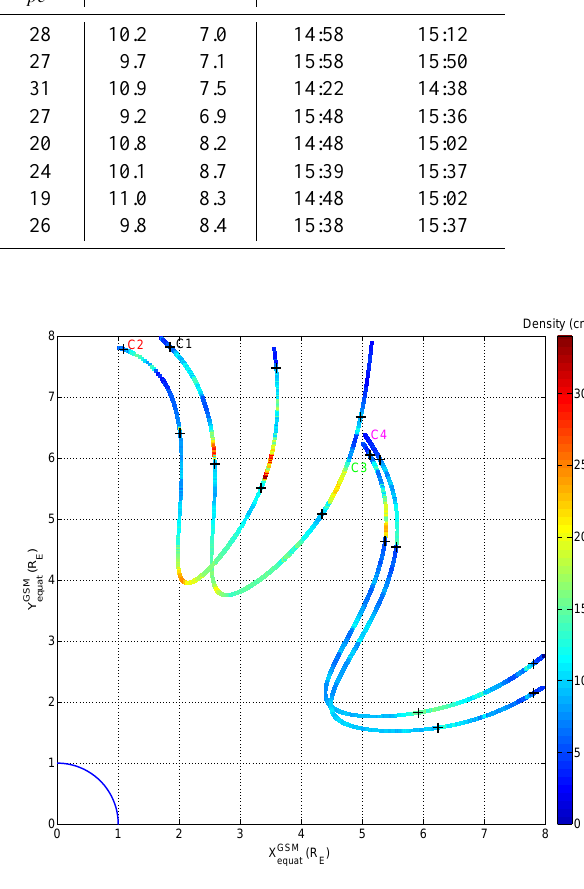
Fig. 4. Electron density plotted along the trajectories of C1, C2 and C3 projected in the R - Z solar magnetic (SM) coordinate sys- tem during the plasmasphere pass on 18 July 2005. The density is plotted with the color scale on the right. The brown lines are dipole magnetic field lines for L between 3 and 8 R E , plotted here to guide the eye. The crosses show the times of the plume crossings T inner and T outer indicated in Table 1.